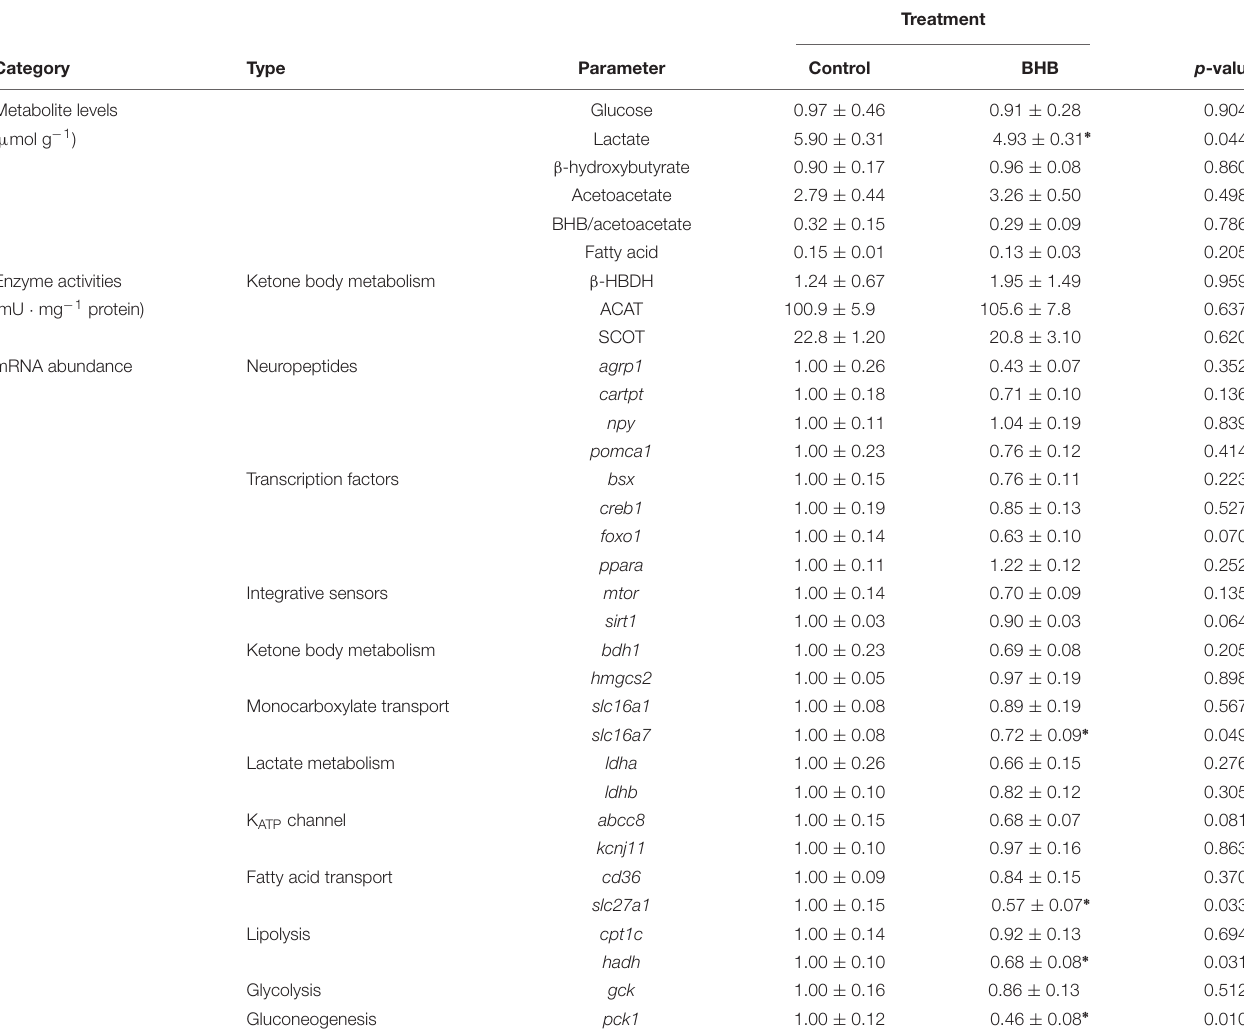
TABLE 3 | Levels of metabolites, enzyme activities, and relative mRNA abundance of transcripts in hypothalamus of rainbow trout 6 h after intracerebroventricular administration of 1 µ L 100 g − 1 body mass of saline solution alone (control) or containing 0.5 µ mol of β -hydroxybutyrate